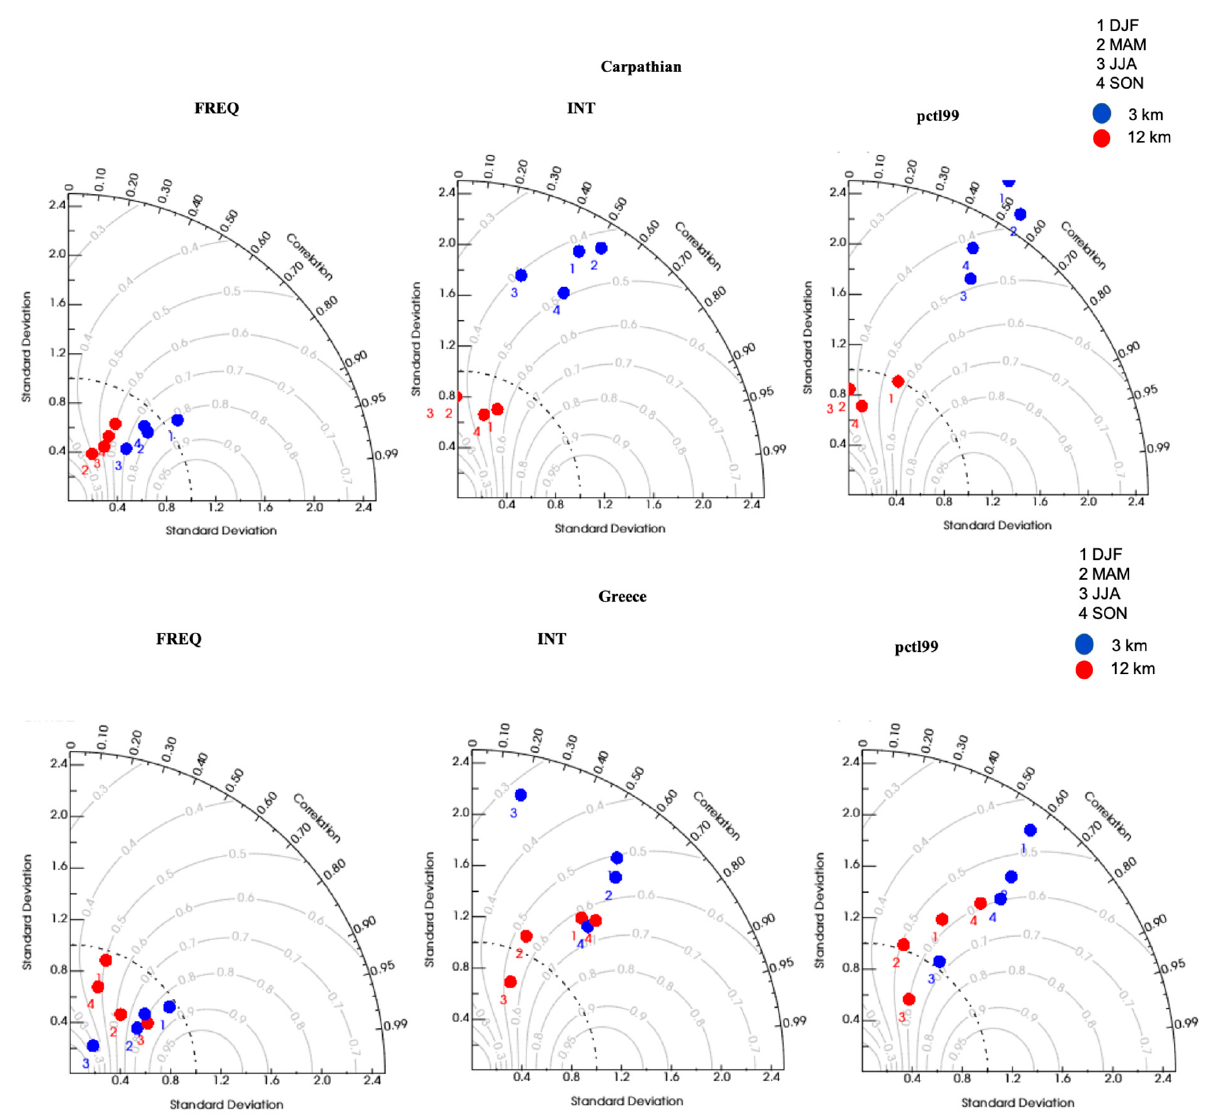
Figure 10. Similar to Figure 9, but for the Carpathians and Greece at a daily scale.